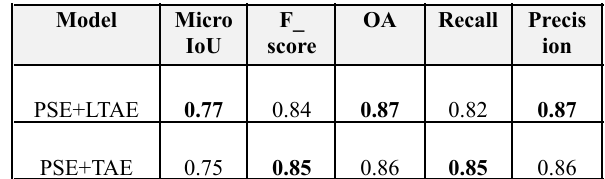
Table 5. Results of (PSE+LTAE) and (PSE+TAE) classification